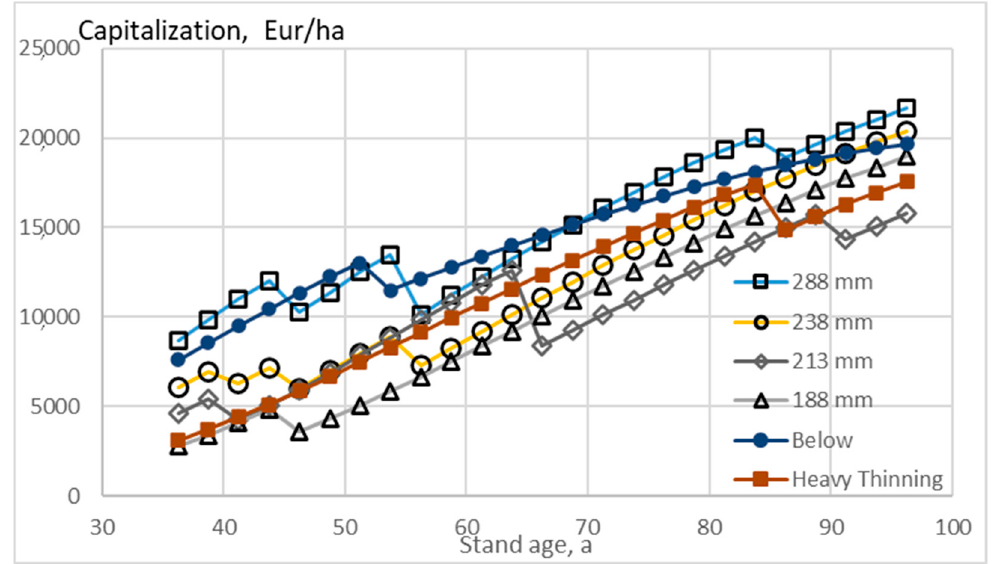
Figure 6. Capitalization per hectare for six different treatments applied on a normal stand representing the example estate. The capitalization is computed for any 30 ‐ month period, without integration over the site lifespan, and without considering any clearcutting price premium or clearcutting harvesting pricing.